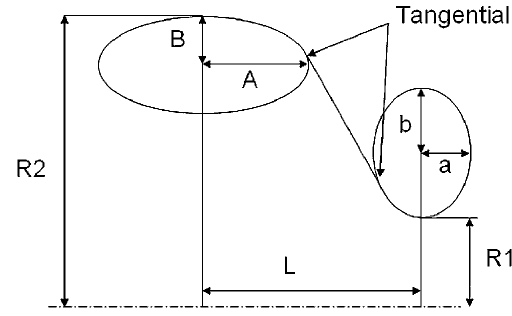
FIG. 1. (Color) Slotted cavity structure.